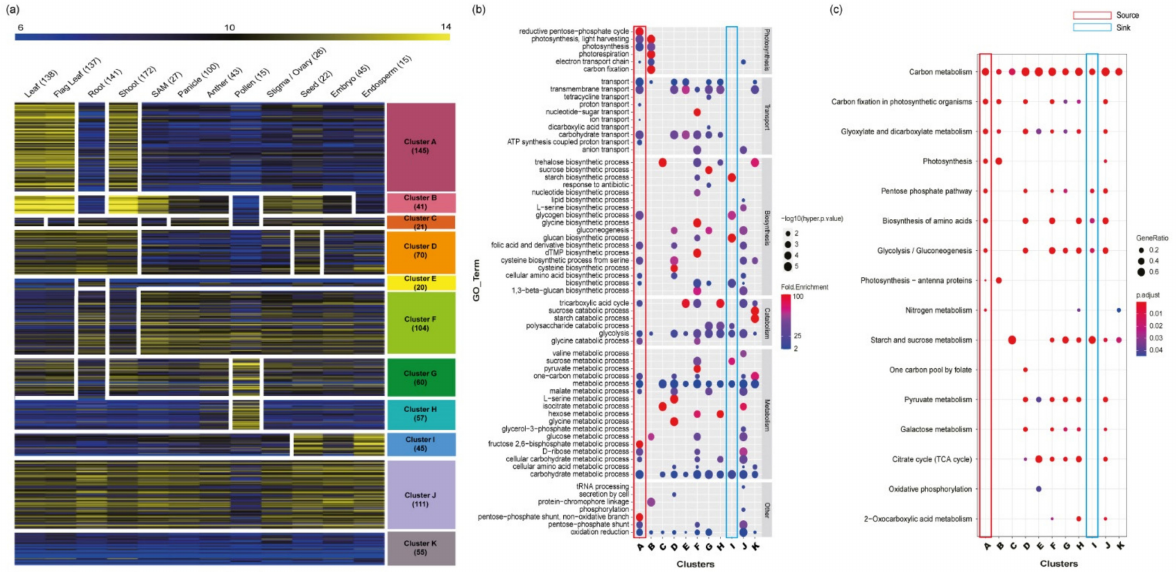
Figure 3. Dissection of the 866 carbohydrate metabolism-related genes using meta-anatomical expression profiles and functional enrichment analysis of 11 anatomical clusters. ( a ) Using large-scale microarray data, carbohydrate metabolism- related genes were visualized and dissected. The heatmap of the anatomical expression profiles of carbohydrate metabolism- related genes was grouped into 11 clusters via KMC clustering methods. The numbers after the name of each tissue/organ indicate the sample size, and the numbers below each cluster indicate the number of genes in the cluster. ( b ) GO enrichment analysis of 11 anatomical clusters. The GO enrichment assay revealed the characteristics of each cluster. GO terms were classified according to biological process GO terms. Dot color indicates the fold enrichment value (the blue color is 2, which is the minimum cutoff to select a significant fold enrichment value, and the red color indicates a higher fold enrichment value), and dot size indicates statistical significance (-log10(hyper p -value) is used, and a larger dot size means more significance). ( c ) KEGG enrichment analysis of 11 anatomical clusters. The enriched KEGG pathway indicated with the dot size represents the ratio of the selected genes to the total genes in the pathway, and the dot color illustrates the adjusted p -value. The numbers below the clusters indicate the number of mapped genes to each pathway. In addition, in GO and KEGG enrichment analyses, the source- and sink-related clusters are highlighted as red and blue boxes,